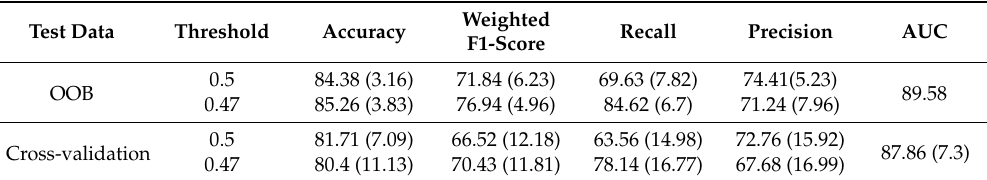
Table 3. Case study results.